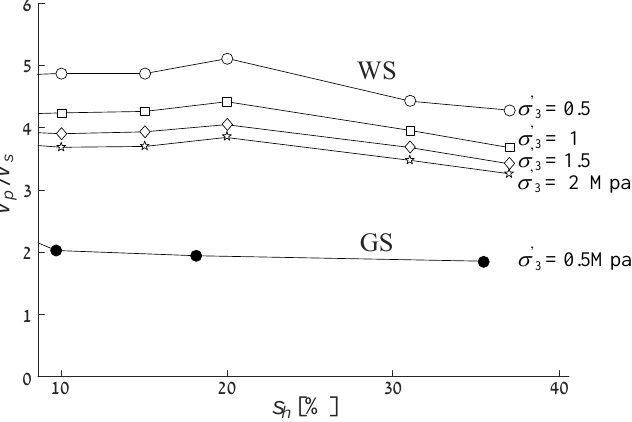
Figure 5. V p / V s ratio as a function of hydrate saturation; filled and empty symbols denote GS and WS testing conditions, respectively. By Priest et al.